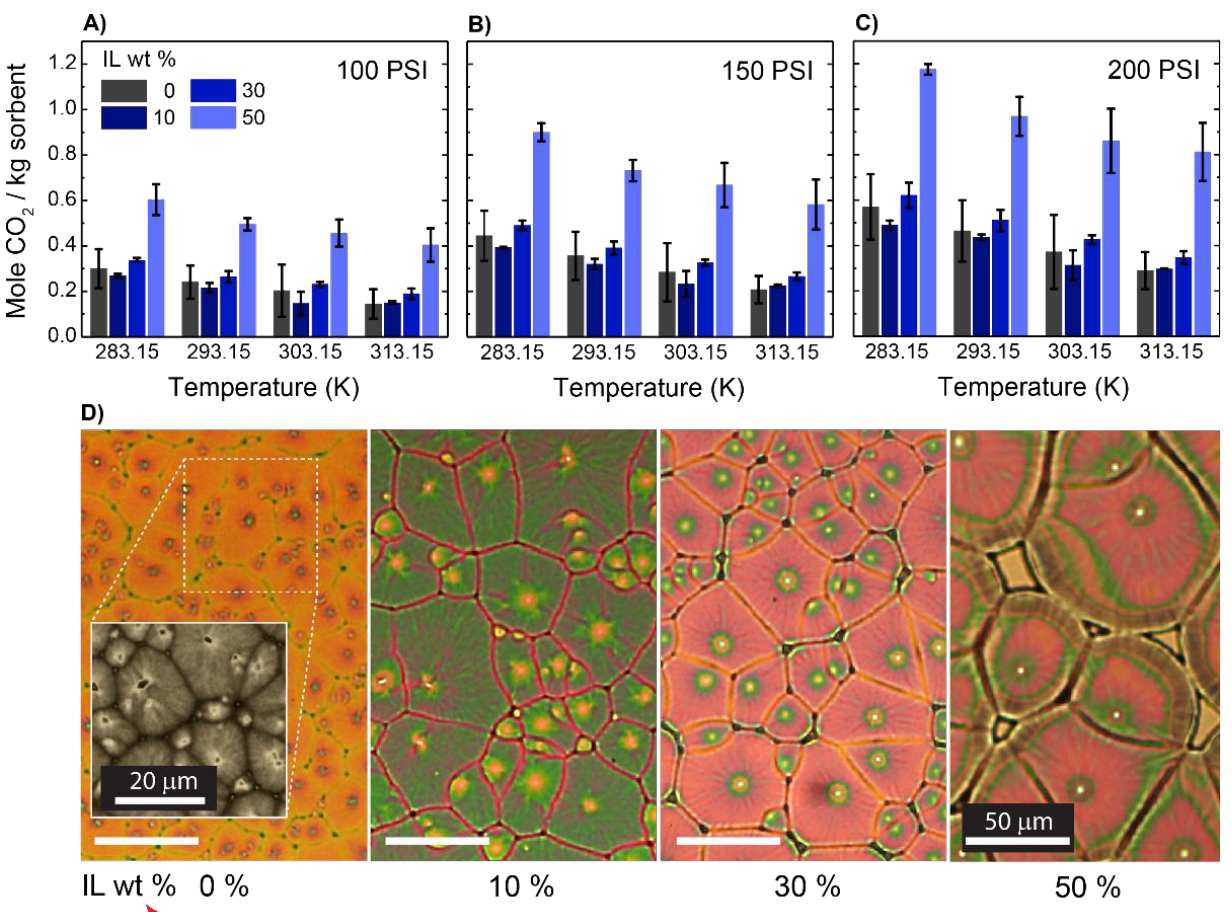
Figure 1. The effect of adding IL on the equilibrium absorption capacity of PVDF-HFP:IL mixtures at three different pressures of ( A ) 100, ( B ) 150, and ( C ) 200 psi. Each data point is the average of four measurements presented with one standard deviation. ( D ) Polarized microscopy images showing the spherulites grown from different mixtures with various IL content. A scale bar is applicable to all subfigures.